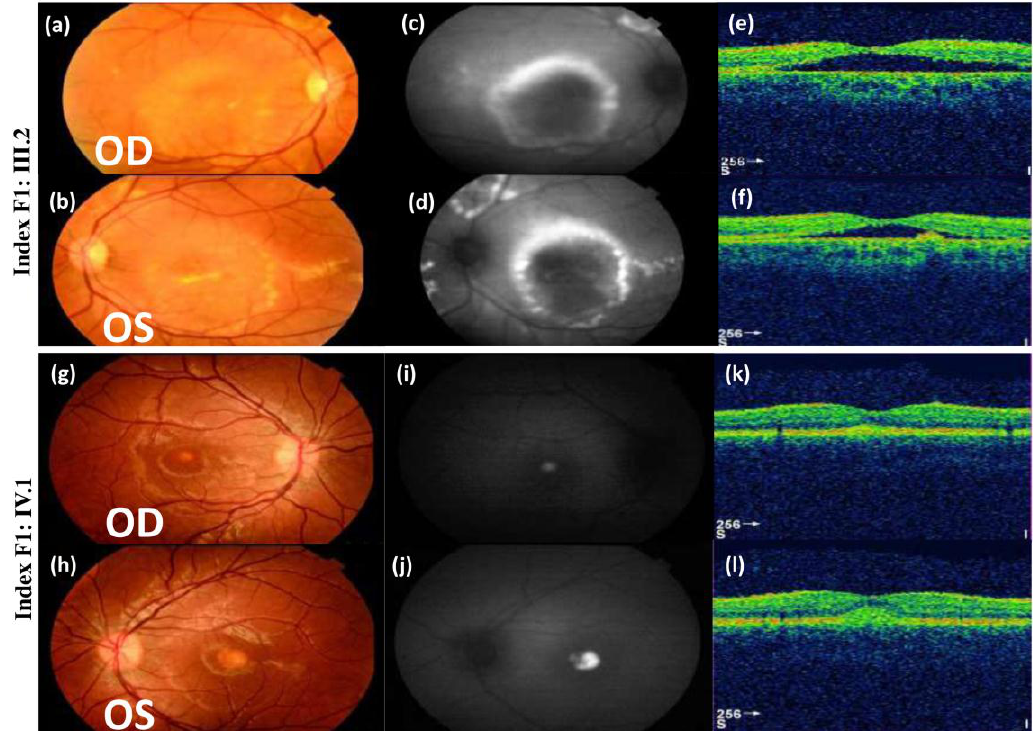
Figure 2. Color fundus photographs ( a , b , g , h ), auto-fluorescence pictures ( c , d , i , j ), and optical coherence tomography scans ( e , f , k , l ) of indexes F1: III.2 and F1: IV.1. Fundus photographs of F1: III.2 showed multifocal vitelliform lesions, subretinal fluid, and intraretinal cysts. Colour fundus photographs of F1: IV.1 showed the presence of a single vitelliform lesion in the posterior pole of both eyes that was hyperautofluorescent on autofluorescence imaging, Optical coherence tomography (OCT) scans showed hyperreflective material at the fovea. OD = oculus dexter; OS = oculus sinister.